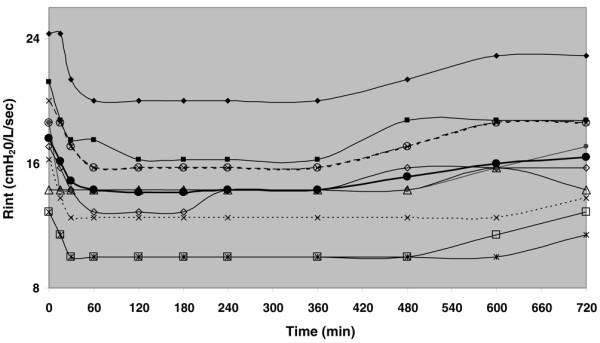
Individual patient values of minimum inspiratory resistance (Rint) before and after salmeterol administration. Baseline values (before salmeterol) are indicated at time 0. The closed circles connected by the thick solid line represent the mean Rint value for the whole patient group. -◆-: Patient #1; -■-: Patient #2; -x-: Patient #3; -✷-: Patient #4; -○-: Patient #5; -●-: Patient #6; -□-: Patient #7; -△: Patient #8; --x--: Patient #9; -◇-: Patient #10.